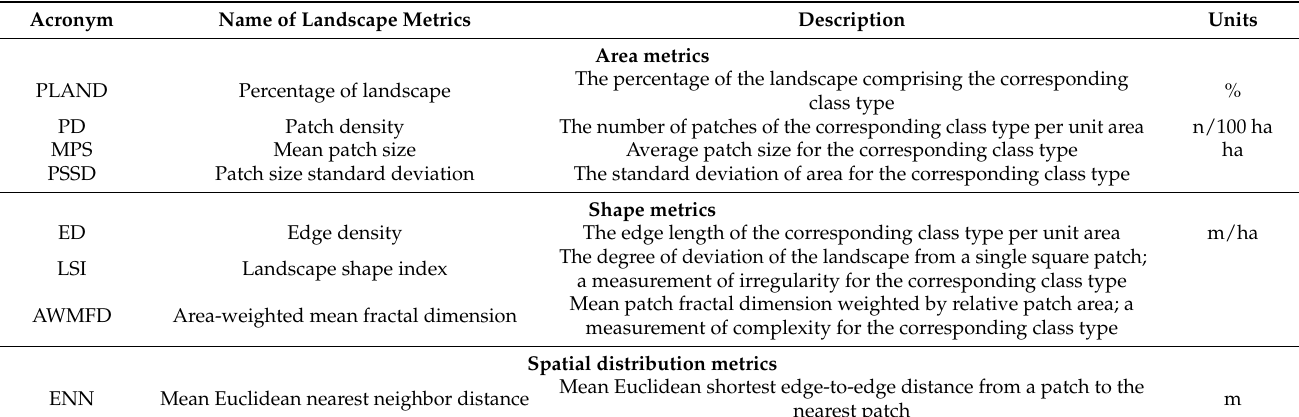
Table 2. Selected landscape metrics used in this